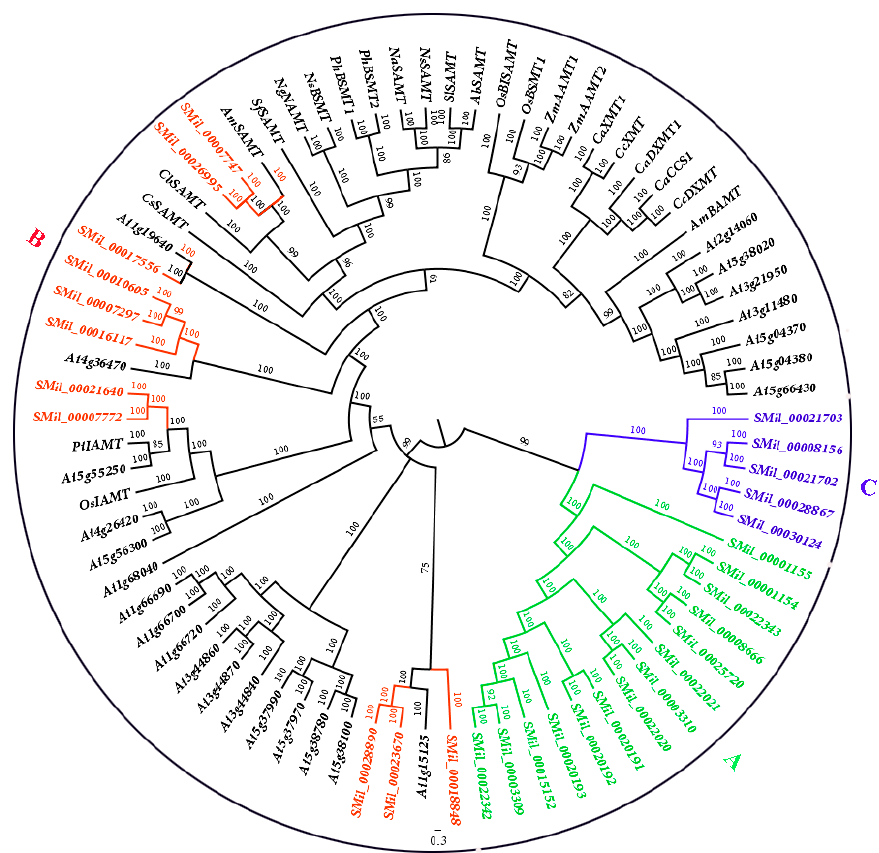
Figure 1. Phylogenetic tree for the SABATH gene family in Salvia miltiorrhiza and other species. The tree was constructed using Bayesian inference implemented in MrBayes, based on the amino acid sequences of the SmSABATH , AtSABATH and other species of the SABATH family under the model of JTT + I + G + F. The members of SmSABATH Groups A, B, and C are marked with green, red, and blue, respectively.